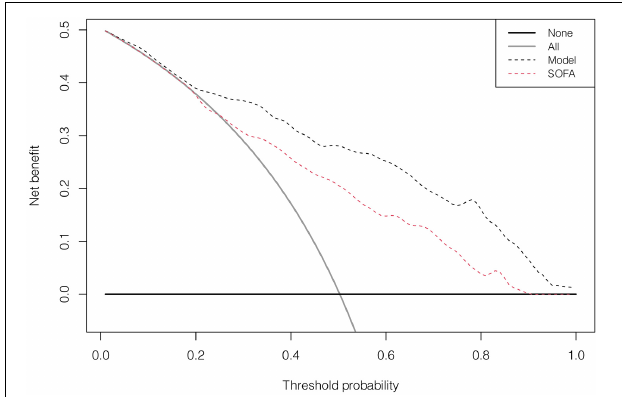
FIGURE 6 | The decision analysis curves of the nomogram and SOFA in discovery cohort.